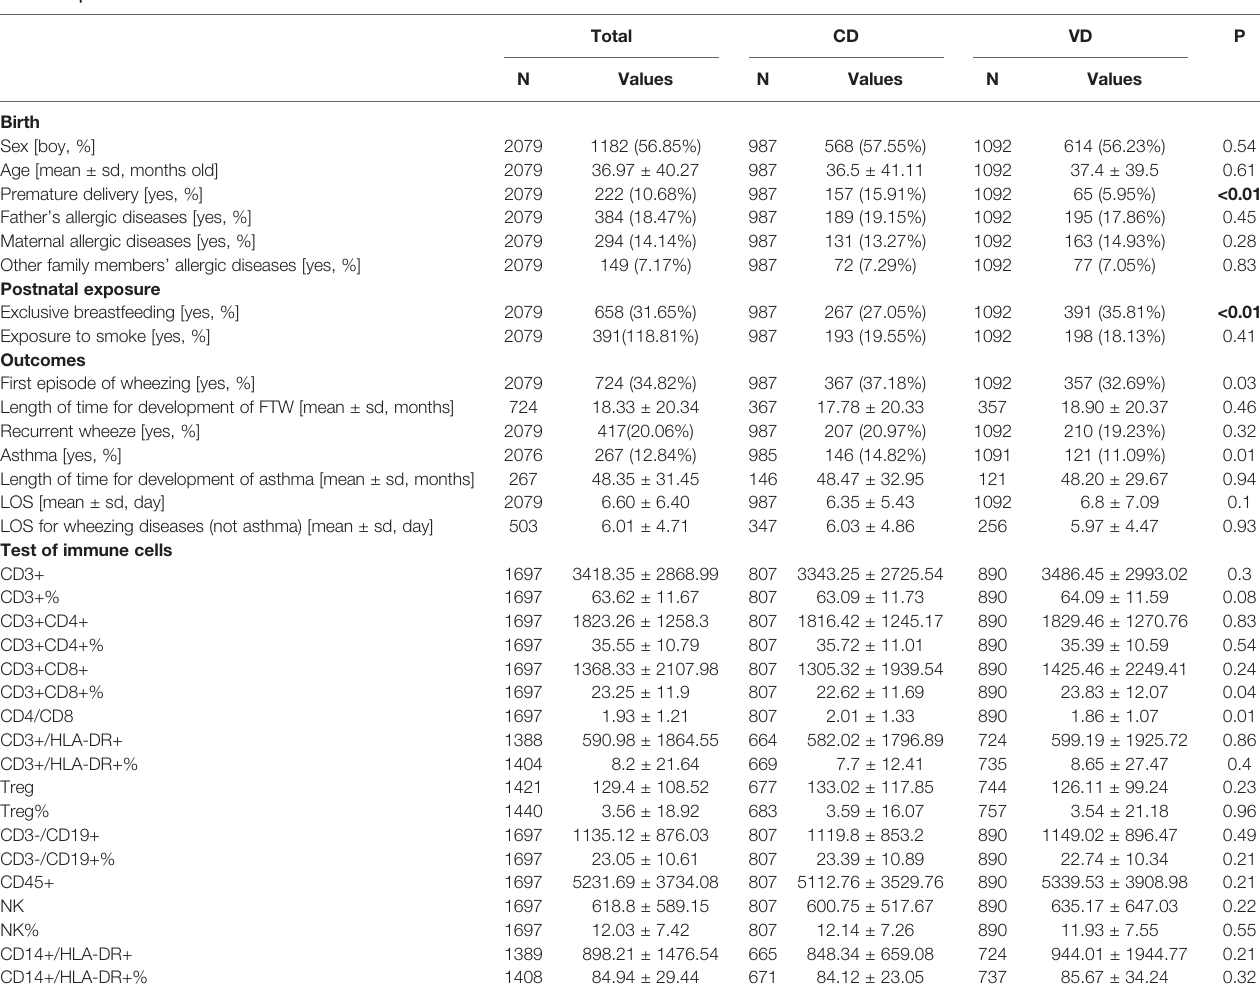
TABLE 1 | The clinical characteristics of included